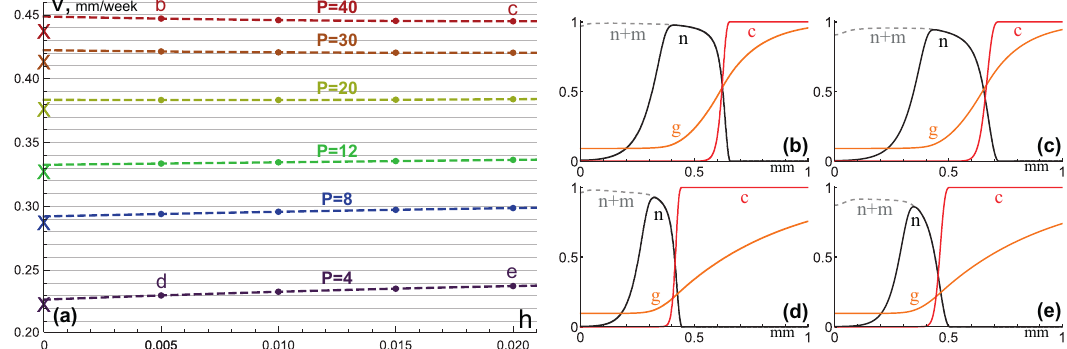
Figure 3. ( a ) The dots denote the values of tumor growth speed V , obtained numerically in the simulations of Equation (1) under designated values of angiogenesis parameter P and space step h , with time step τ = h 2 , D n = 0, and the values of other parameters taken from the basic set. The dashed lines represent the best fit quadratic functions for every value of P . The crosses on the vertical axis mark the analytically derived values of tumor growth speed for the values of P used. ( b – e ) The distributions of the model variables on the 20th day of simulations under the values of the parameters, designated by the corresponding letters in ( a